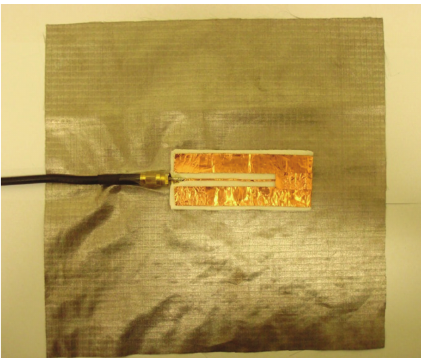
Figure 13: Fabricated antenna with SMA connector for impedance